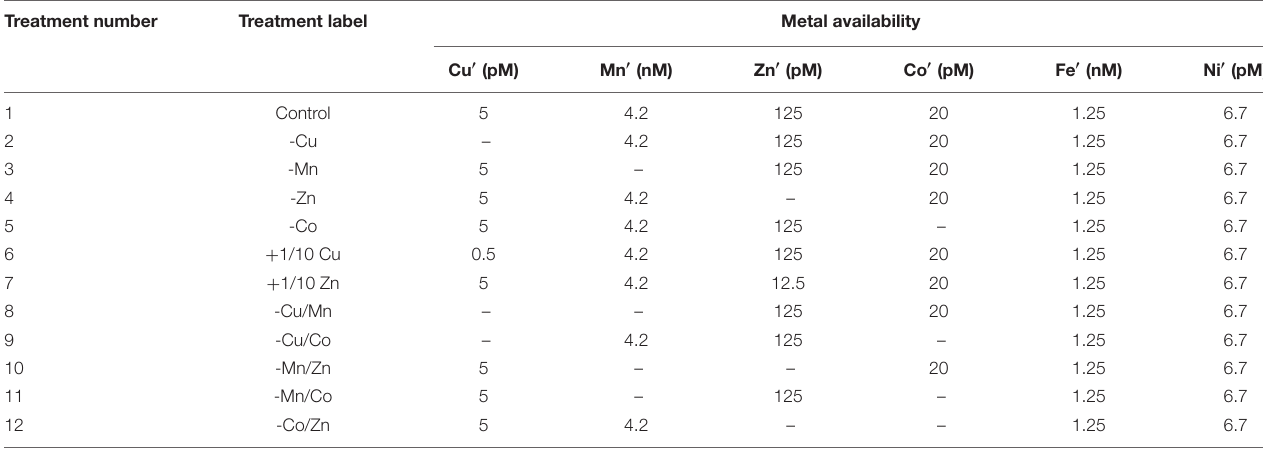
TABLE 1 | Trace metal concentrations in batch cultures to investigate the interactive effects of Cu, Zn, Mn, and Co on Symbiodinium kawagutii growth. Treatment number Treatment label